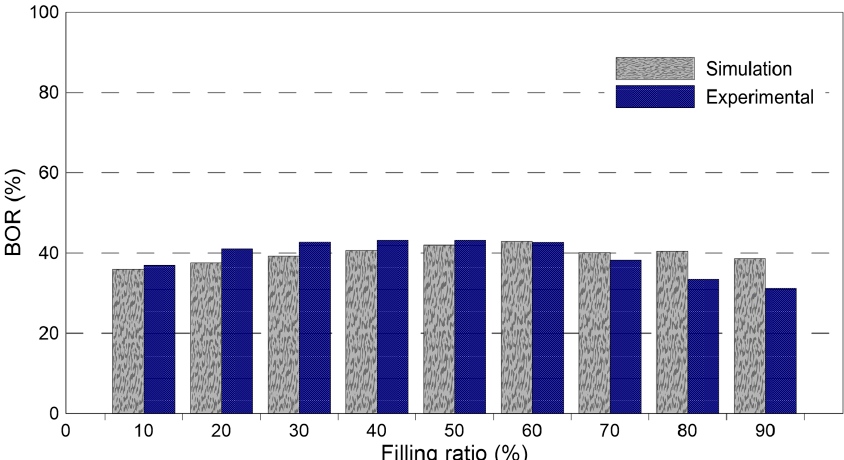
Figure 12. Comparison of BOR with simulation and